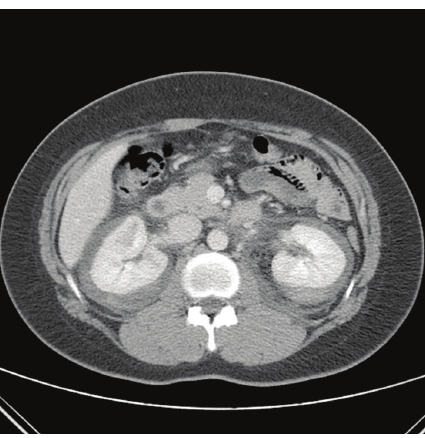
Figure 1: Contrast enhanced CT on the day of admission. CT revealed nonspecific spontaneous bilateral perirenal hemorrhage and delayed enhancing lesion of renal